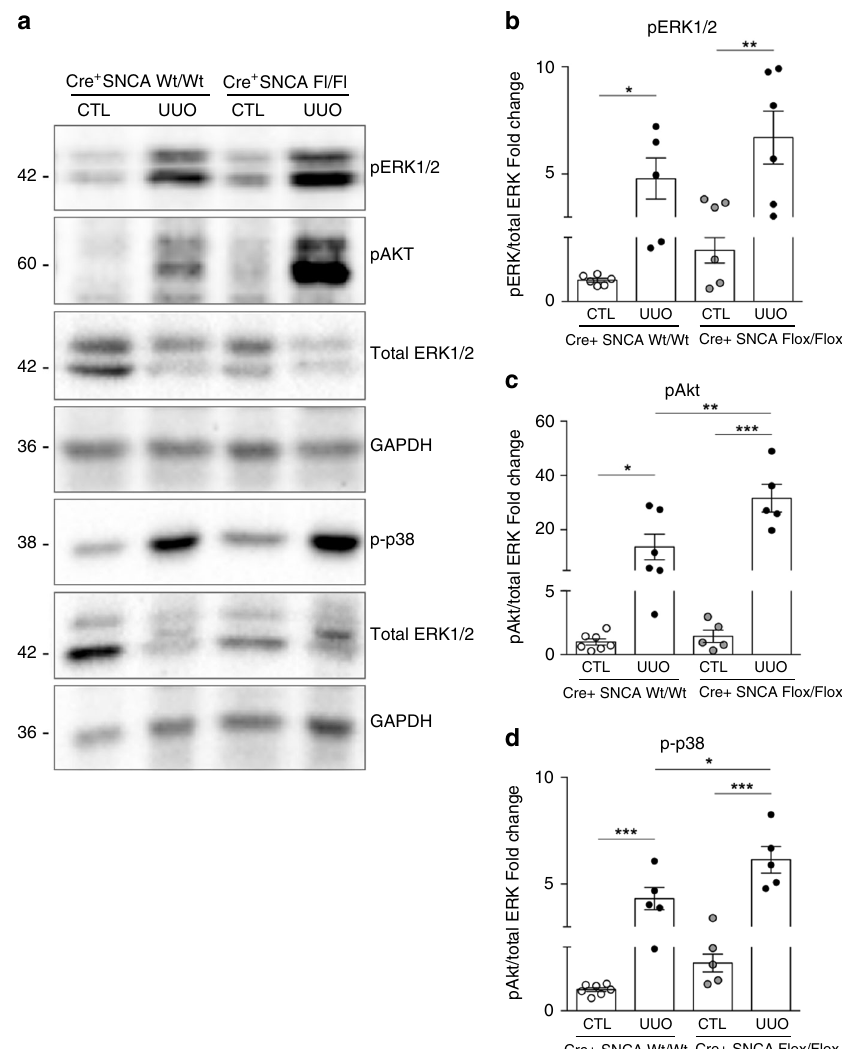
Fig. 9 SNCA modulates the activation of ERK1/2, Akt and p38 after UUO. PEPCK Cre + SNCA wt/wt and PEPCK Cre + SNCA fl / fl mice were subjected to UUO and sacri fi ced 5 days after obstruction. Whole kidney lysates from contralateral non-obstructed (CTL) and obstructed (UUO) kidneys were processed for protein analysis and were immunoblotted with antibodies against pERK1/2, pAkt, p-p38, total ERK1/2 and GAPDH. a Representative Western blots and quantitative densitometric analysis b – d levels of phosphorylated ERK1/2 ( a , b ), Akt ( a , c ) and p38 ( a , d ) in the kidneys of PEPCK Cre + SNCA wt/wt and PEPCK Cre + SNCA fl / fl mice subjected to UUO. Data were normalized to total ERK1/2 and presented as mean ± SEM ( n = 7 mice/group) (fold change over CTL PEPCK Cre + SNCA wt/wt ). * p < 0.05, ** p < 0.01, *** p < 0.001. The p -value by two-way ANOVA. Source data are provided as a Source Data fi